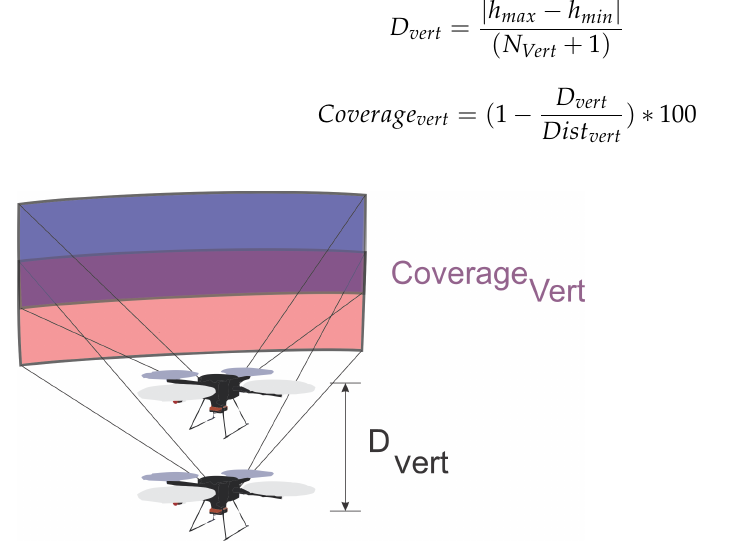
Figure 5. Vertical